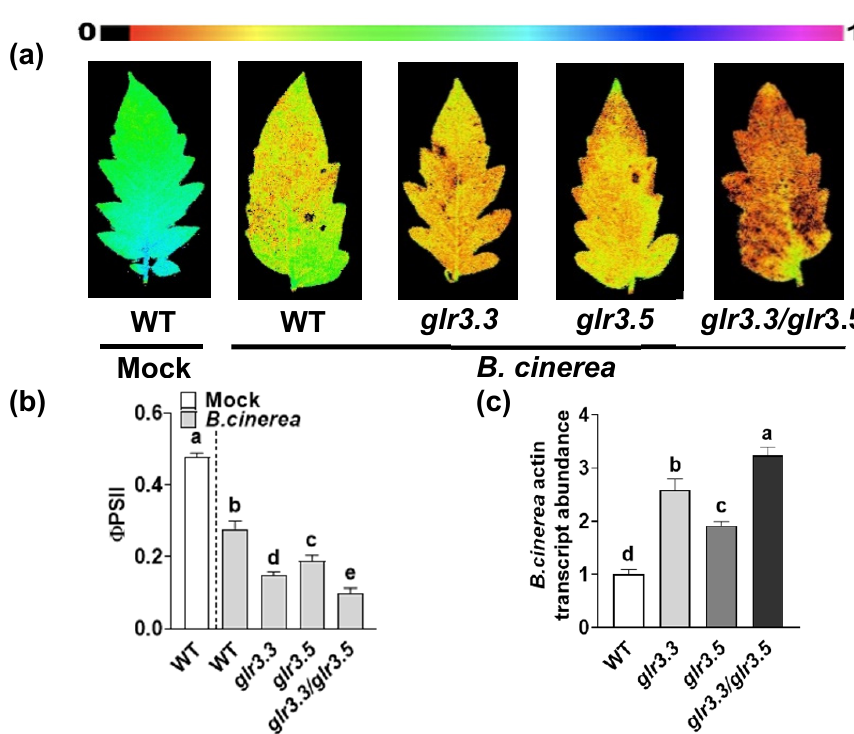
Figure 3. Effects of GLR3.3 and GLR3.5 editing on plant defense against B. cinerea inoculation in